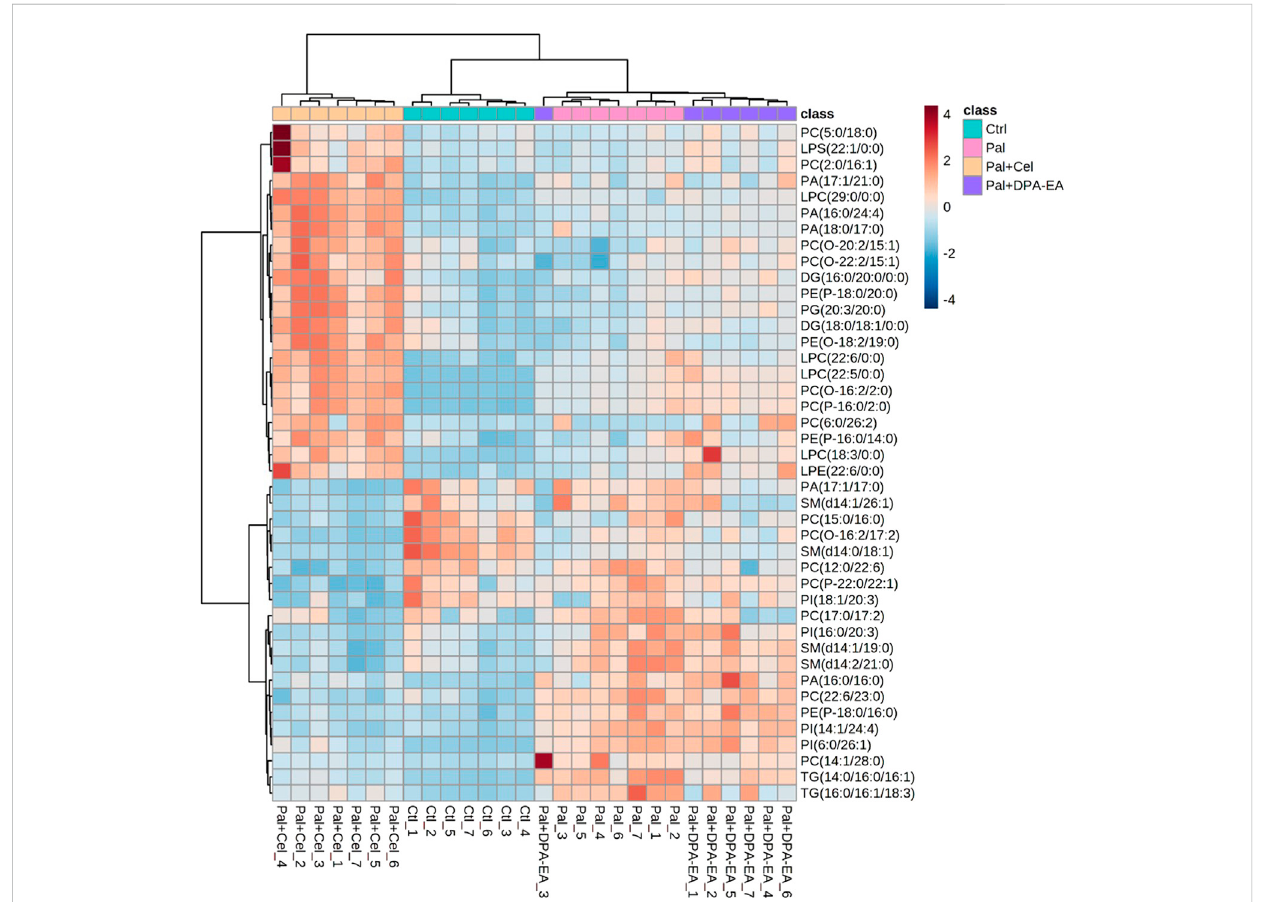
FIGURE 6 Heatmap of DELs only in the Pal + Cel vs. Pal model, not in the Pal + DPA-EA vs. Pal model, selected with the fold change cutoff of FC > 1.6 or FC < 0.5 as upregulated and downregulated, respectively. Red and blue indicate increased and decreased lipids, respectively.